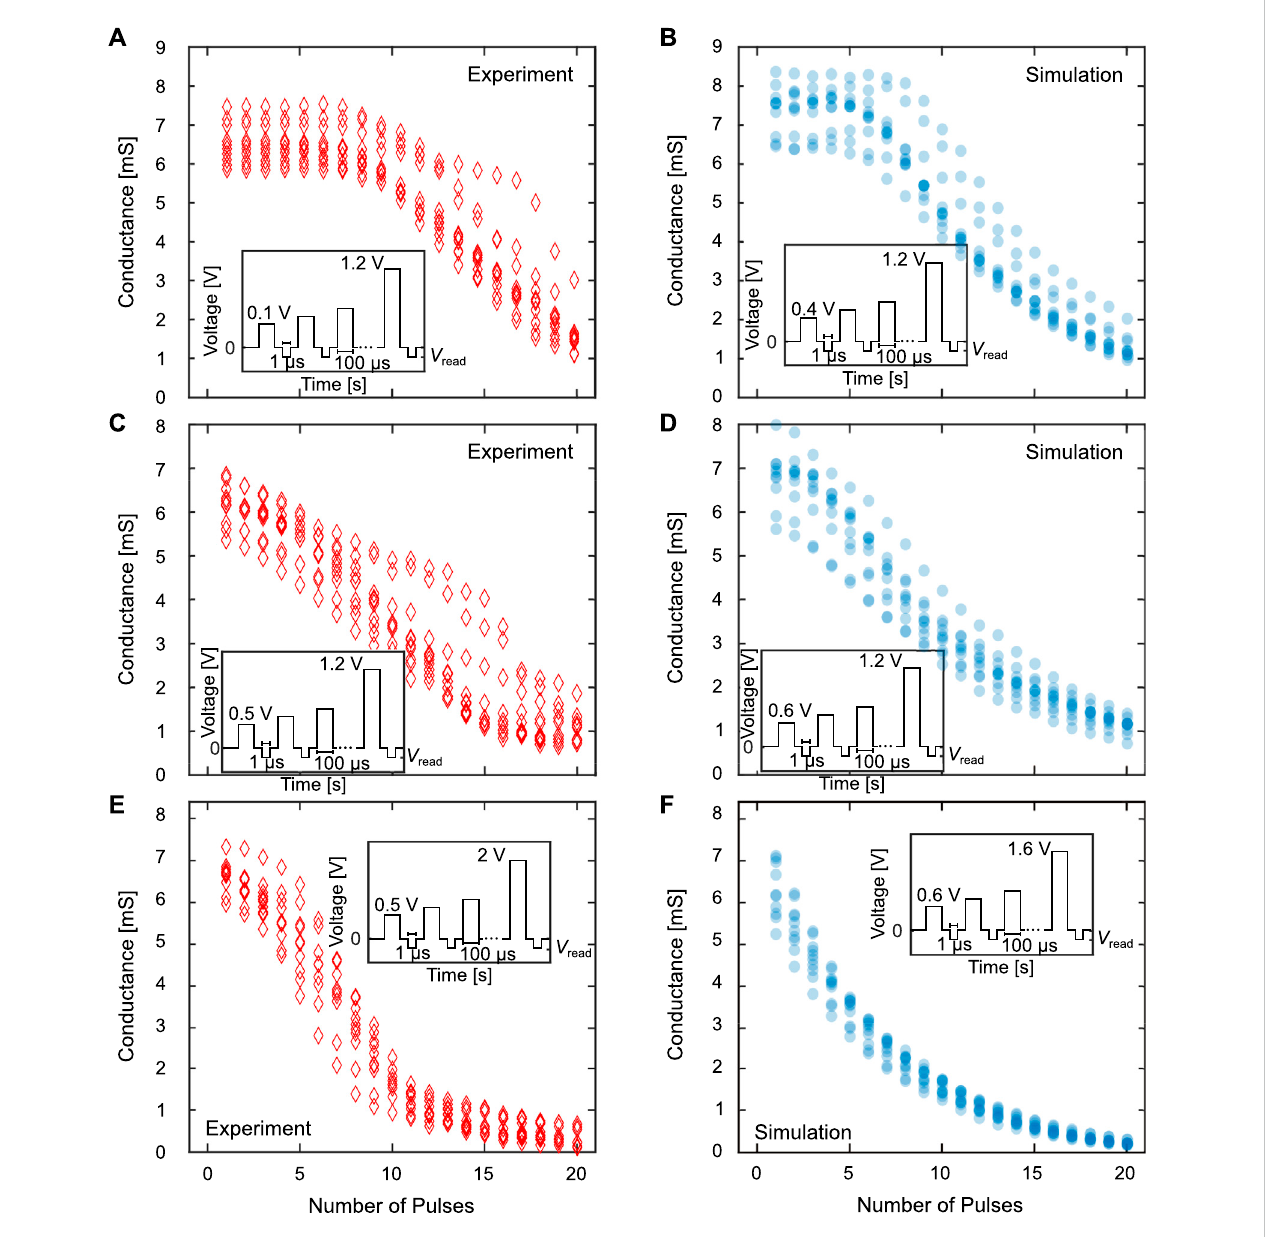
FIGURE 10 Comparison of the delay regime (A) and (B) , the linear regime (C) and (D) and the saturation regime (E) and (F) between experiment (left) and simulation (right for the depression or RESET direction and for N = 8. The conductances shown are the conductance of the complete synapse. The insets describe the pulse schemes with the applied voltages and pulse